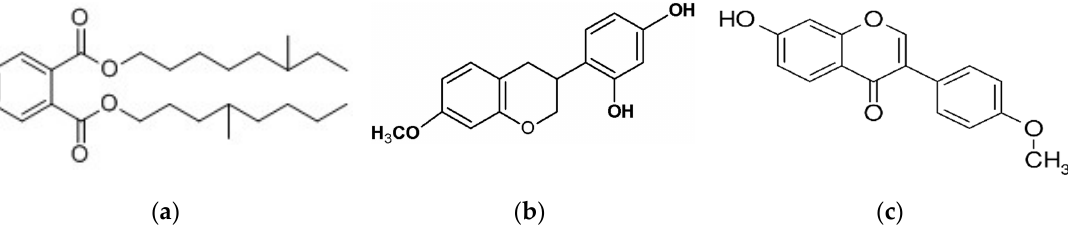
Figure 3. Chemical structure of the main red Brazilian propolis markers ( a ) vestinol; ( b ) neovestinol; ( c ) formononetine.